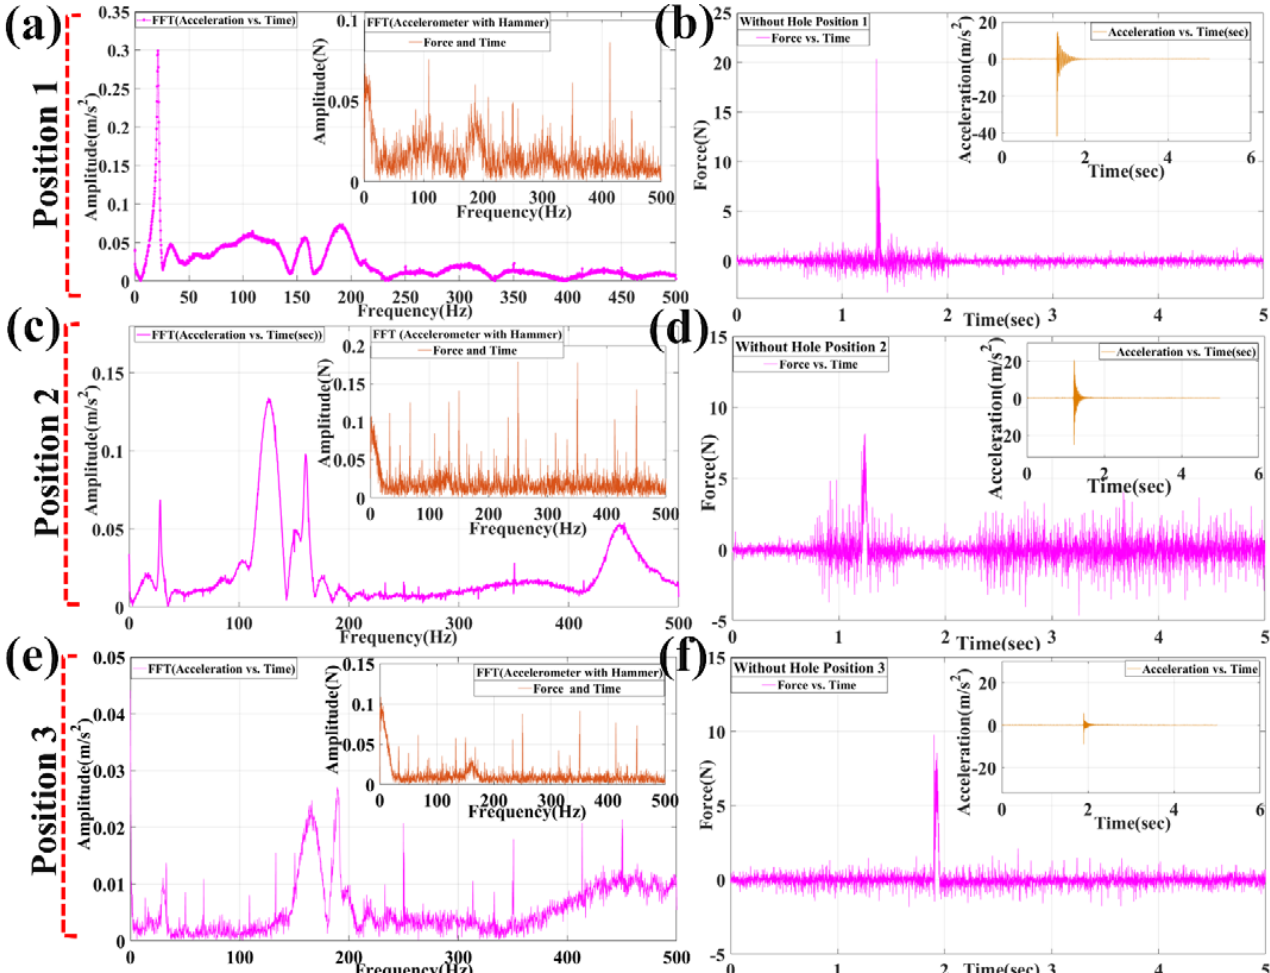
Figure 6. FFT graph plotted by MATLAB 2016 for obtaining modes of frequencies from acceleration and force amplitude with respect to time and its corresponding magnitude graphs at different positions of impact hammering (without hole): ( a , b ) FFT graphs and magnitude graphs for acceleration and force for position 1; ( c , d ) FFT graphs and magnitude graphs for acceleration and force for position 2; ( e , f ) FFT graphs and magnitude graphs for acceleration and force for position 3.